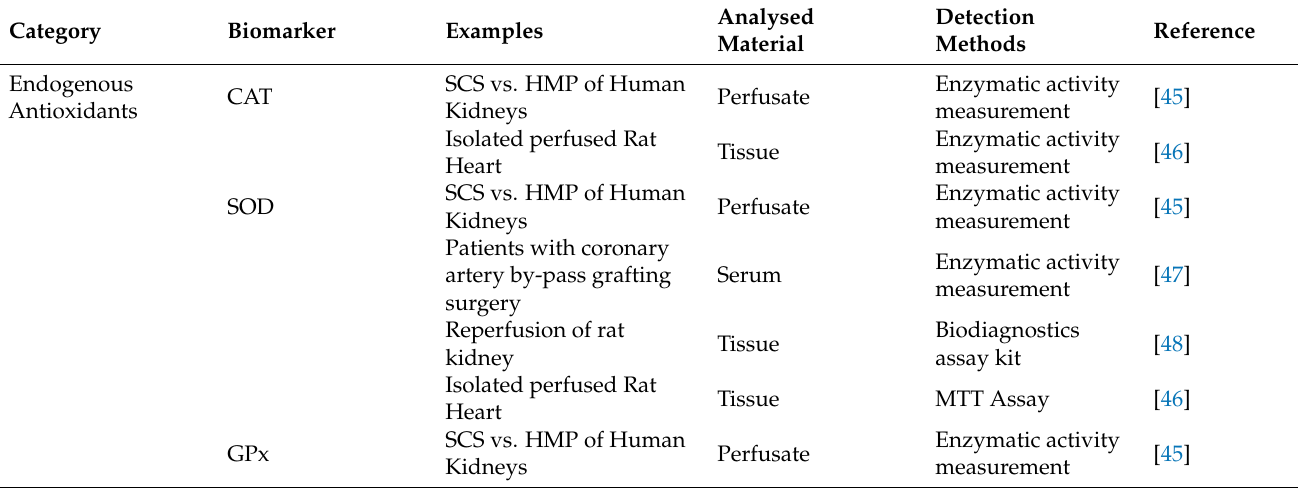
Table 1. Potential biomarkers for oxidative